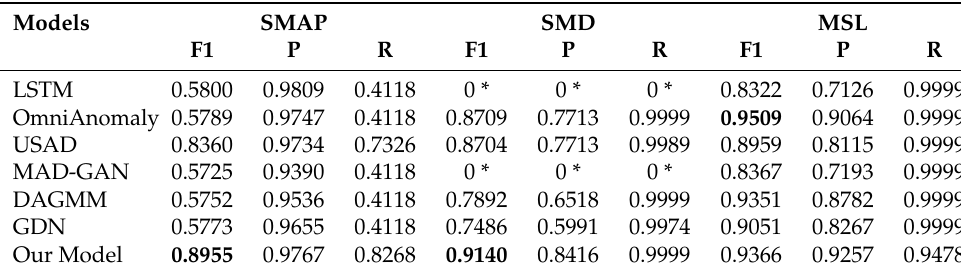
Table 2. Anomaly detection performance metrics on three datasets. The best results are highlighted in